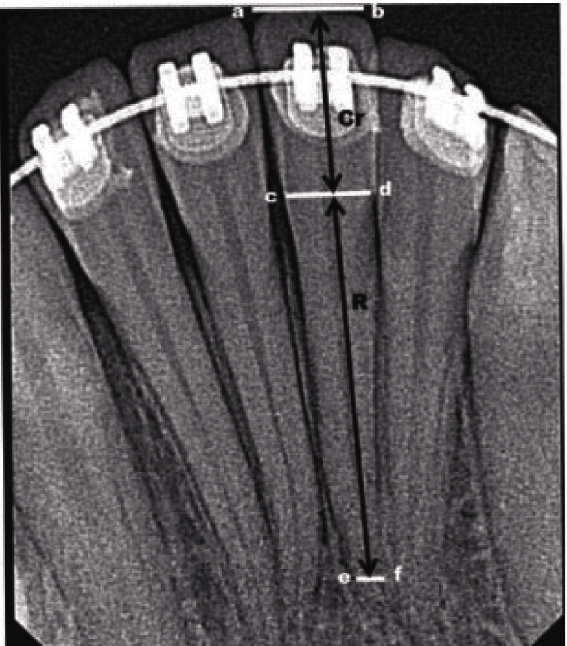
Figure 1: Root length measurement (a) mesial incisal edge point; (b) distal incisal edge point; (c) mesial cementoenamel junction point; (d) distal cementoenamel junction point; (e) mesial edge point of the apical foramen; (f) distal edge point of the apical foramen; (Cr) crown length; (R) root